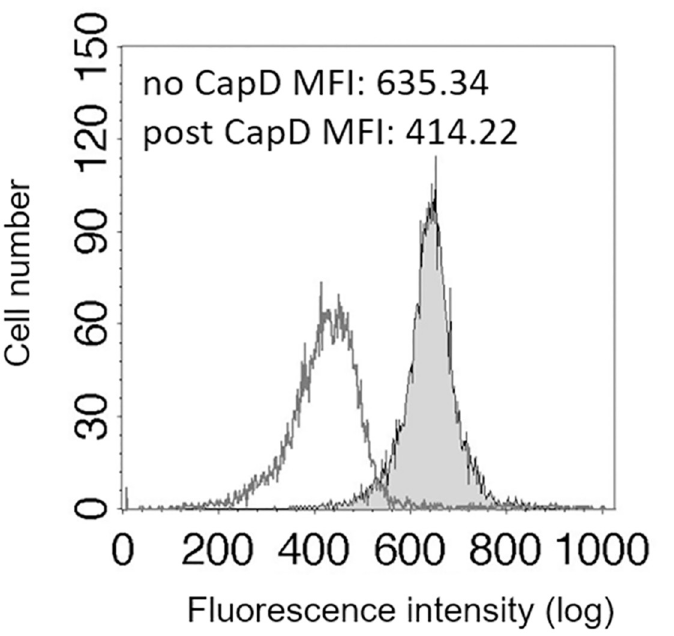
Fig 6. Encapsulation reduces the amount of HBD-3 reaching the bacillus cell wall. Encapsulated killed WT bacilli were incubated with 20 ug Atto-594-labeled HBD-3. A portion of the bacilli was subsequently treated with CapD to remove the capsule. Atto-594-labeled HBD-3 binding was measured by flow cytometry. The grey filled histogram represents bacilli without CapD treatment. The white filled histogram represents CapD treated bacilli. Four experiments were done (n = 4). Data from a single representative experiment are shown.